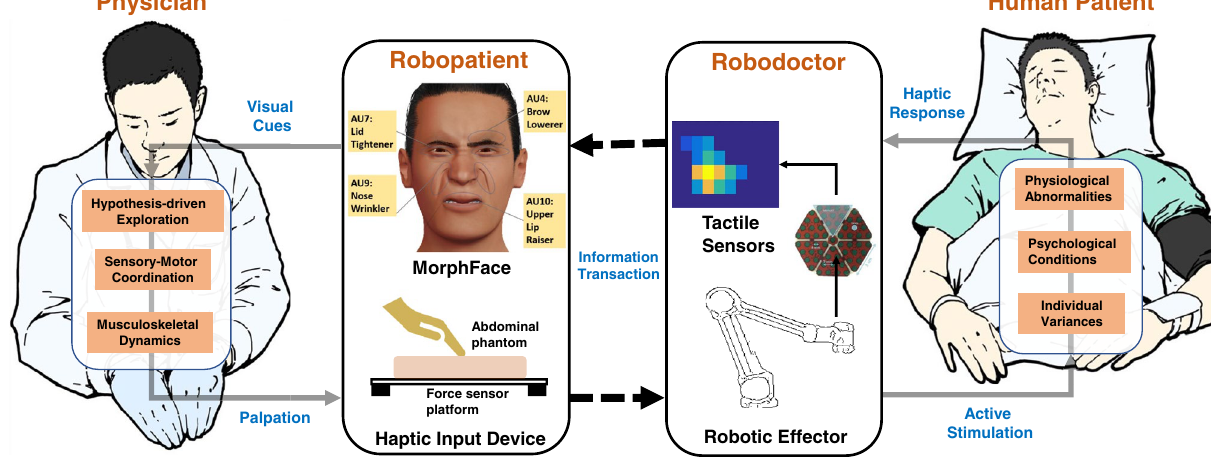
Figure 1. Face mediated human–robot interaction approach for remote palpation. The system consists of four main subsystems: a physician, a robopatient, a robodoctor, and a human patient. The human